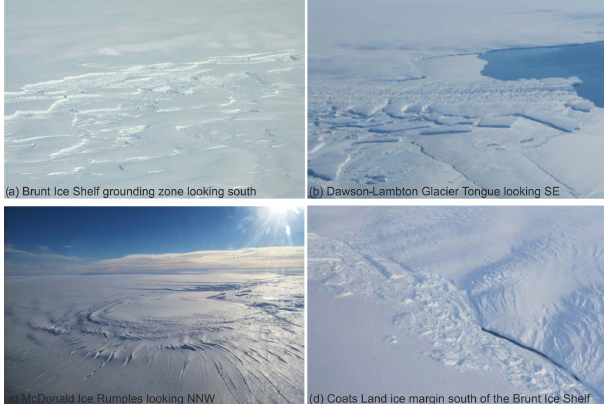
Figure 2. Images of key ice shelf features. Approximate locations of a–c in Fig. 1. (a) The grounding line of the Brunt Ice Shelf show- ing the 10–20km wide zone of icebergs which eventually “fuse” together with sea ice and falling and drifting snow layers to form a structurally heterogeneous ice shelf. (b) The Dawson-Lambton Glacier Tongue, which fails to reconnect with the bed. (c) The Mc- Donald Ice Rumples showing where the ice shelf is deflected around a topographic high on the McDonald Bank, oblique aerial photo- graph facing NNW in 2017. (d) Part of the Coats Land ice margin south of the Brunt Ice Shelf, which calves directly into the Weddell Sea. Photograph taken of the coast immediately south of the study area in Fig.